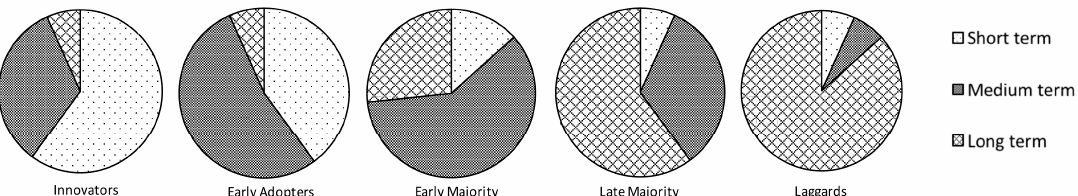
Figure 3. Stakeholder views on the adoption of citizen science initiatives by Commercial Organizations. Short term: less than or equal to three years; Medium term: between three and five years; and Long term: between five and 15 years.